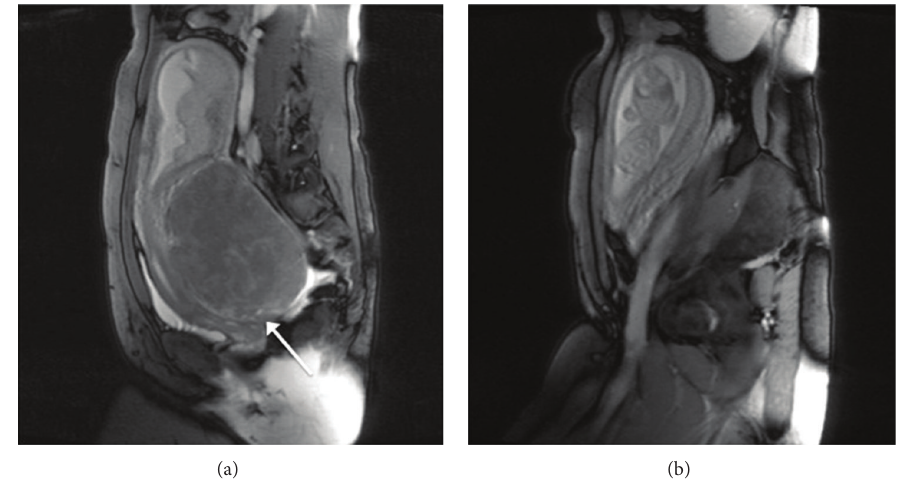
Figure 2: Bulky leiomyoma occupying the pouch of Douglas with signs of compression of ureters, bladder, sigma-rectus, and the gestational chamber; the presence of bulky leiomyoma (20 × 18cm) with large base of implant (12cm) occupying the pouch of Douglas. MRI also showed other multiple nodes, of which the bigger was of diameter 4